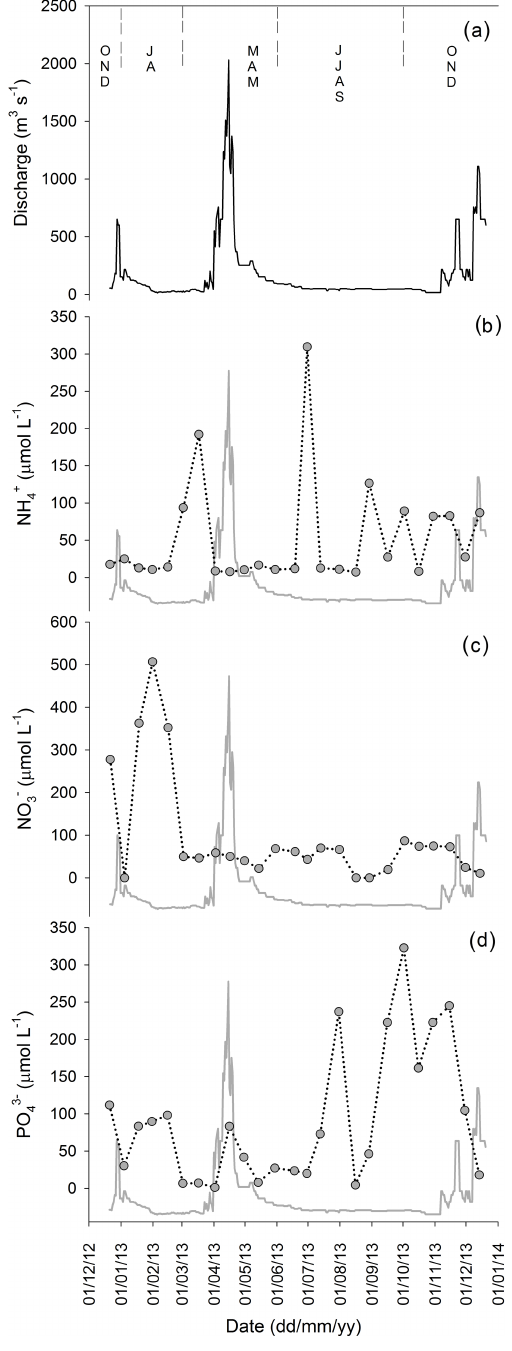
Figure 6. (a) Daily discharge rates and 1 year of monitoring the concentration of dissolved (b) ammonium, (c) nitrate and (d) phos- phate in the Sabaki River. In panels (b) – (d) grey circles represent bulk concentrations.